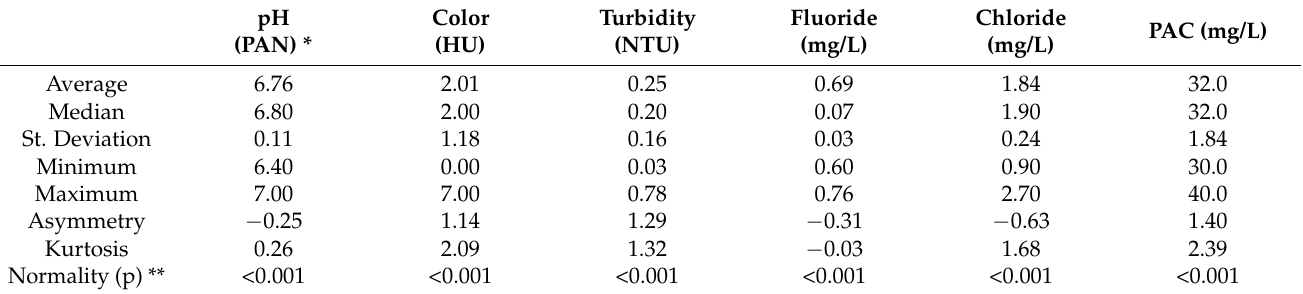
Table 1. Database with quality indicator parameters of raw water and